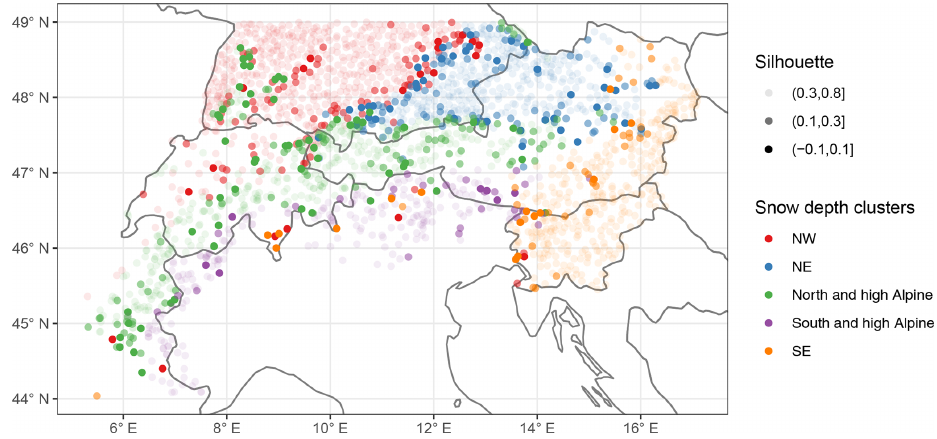
Figure B1. Silhouette values of the stations which show the consistency of clustering. The silhouette is a measure of how similar the station is to its own cluster compared to the other clusters (see Sect. 2.4). High values indicate a good match, while low and negative values indicate a poor match.